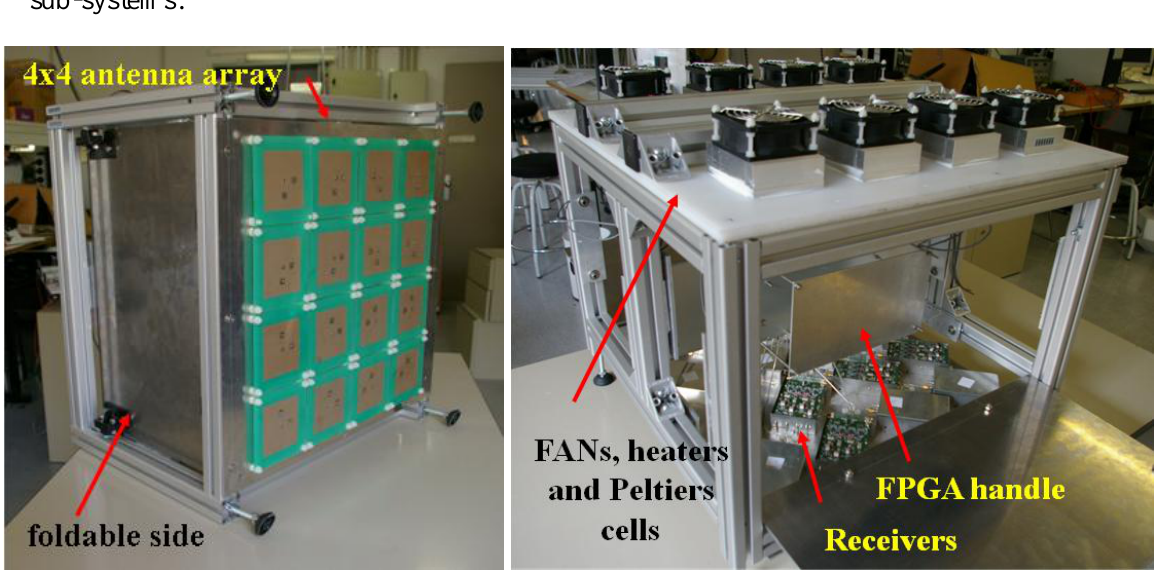
Figure 6. Installation of the PAU-RAD instrument on a 110 × 120 × 80 cm structure. On the left side, a frontal perspective with the 4 × 4 element array. On the right side, a back overview with the receivers, the thermal control sub-system and other PAU processors